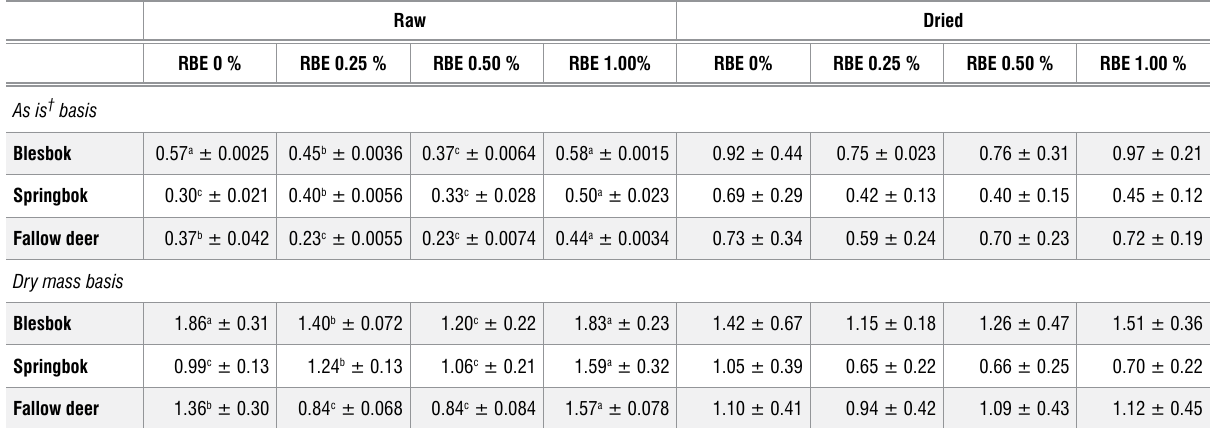
Table 5: Means±s.d. for lipid oxidation (mg MDA/kg meat) of game droëwors with added rooibos extract (RBE). Raw Dried RBE 0 % RBE 0.25 % RBE 0.50 % RBE 1.00% RBE 0% RBE 0.25 % RBE 0.50 % RBE 1.00 % As is † basis Blesbok